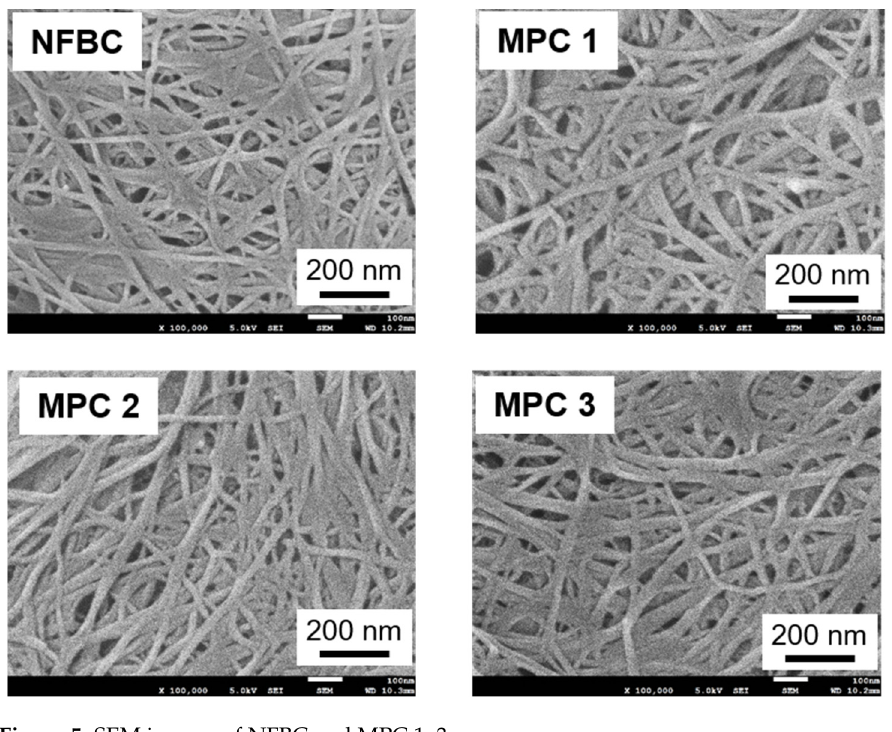
8 of 16 Figure 4. Thermal gravimetry/differential thermal analysis (TG/DTA) data for MPC 1–3 and NFBC. 3.2. MPC Sample Morphologies